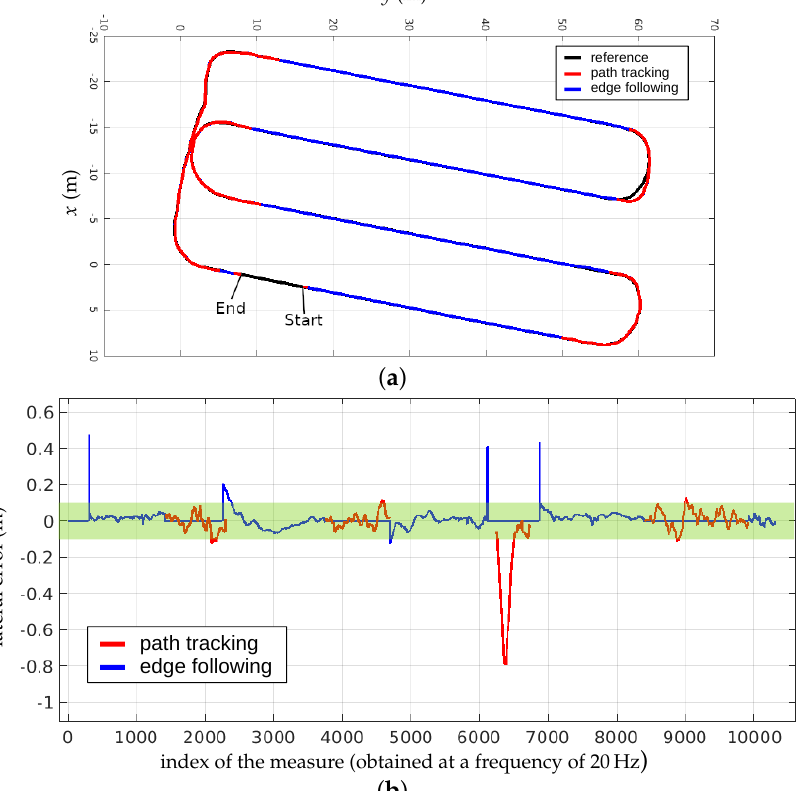
Figure 10. Results of experiment 2. ( a ) Absolute position ( x , y ) of the robot. In red, the robot is in path tracking mode; in blue, it is in furrow pursuing mode. The black trajectory corresponds to reference trajectory to follow. ( b ) Lateral error in the Frénet frame of the local trajectory. For path tracking (in red), the local trajectory is the reference trajectory, and for furrow pursuing (in blue), it is built from the furrow